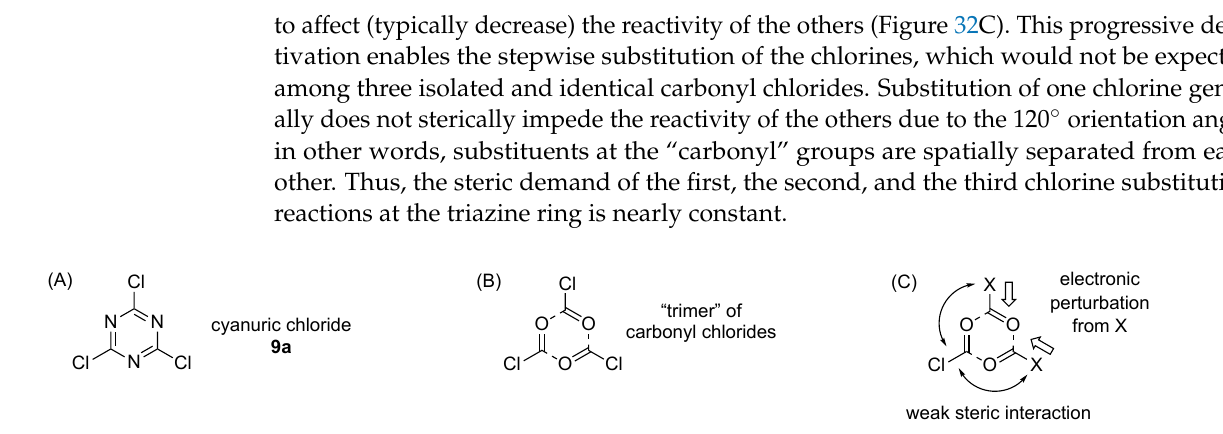
Figure 32. ( A ) Structure of cyanuric chloride; ( B ) analogy of cyanuric chloride to a formal trimer of carbonyl chlorides; and ( C ) electronic and steric effects of the substituent X.